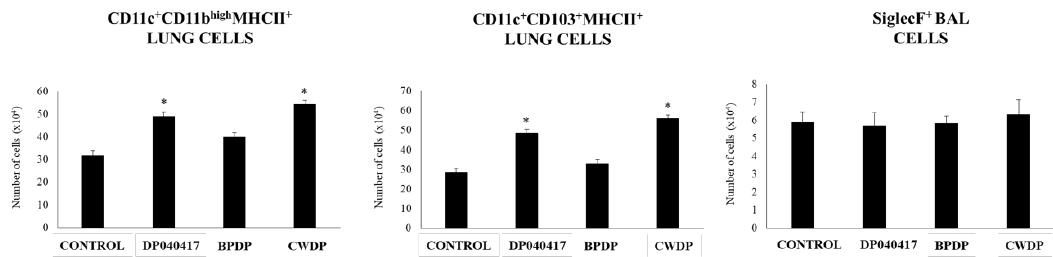
Figure 5. E ff ect of Dolosigranulum pigrum 040417 on respiratory immune cell populations. Viable (DP), bacterium-like particles (BPDP) or cell wall (CWDP) from D. pigrum 040417 were nasally administered to infant mice during five consecutive days. Non-treated infant mice were used as controls. The numbers of MHC-II + CD11c + CD11b low CD103 + and MHC-II + CD11c + CD11b high CD103 - dendritic cells in lungs, and CD45 + MHC-II - CD11c + SiglecF + alveolar macrophages in broncho-alveolar lavages (BAL) were determined by flow cytometry one day after the last treatment. Experiments were performed with 5–6 mice per group. The results represent data from three independent experiments. Significantly di ff erent when compared to control * p < 0.05 or ** p < 0.01